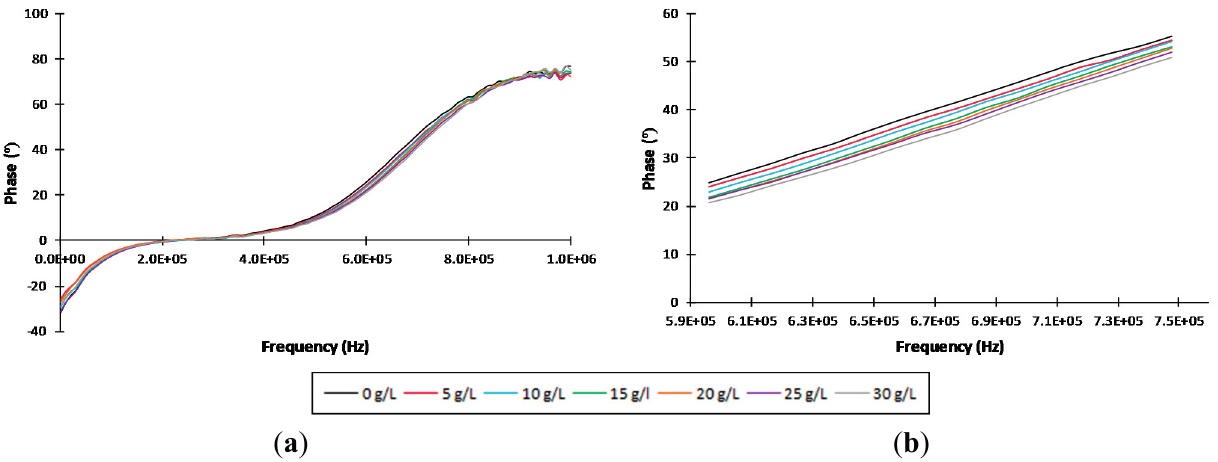
Figure 3. Averaged phase values of the impedance spectra of different sucrose concentration measurements for ( a ) the entire analyzed frequency range and ( b ) the selected range for data treatment (5.96 × 10 5 Hz–7.47 × 10 5 Hz).